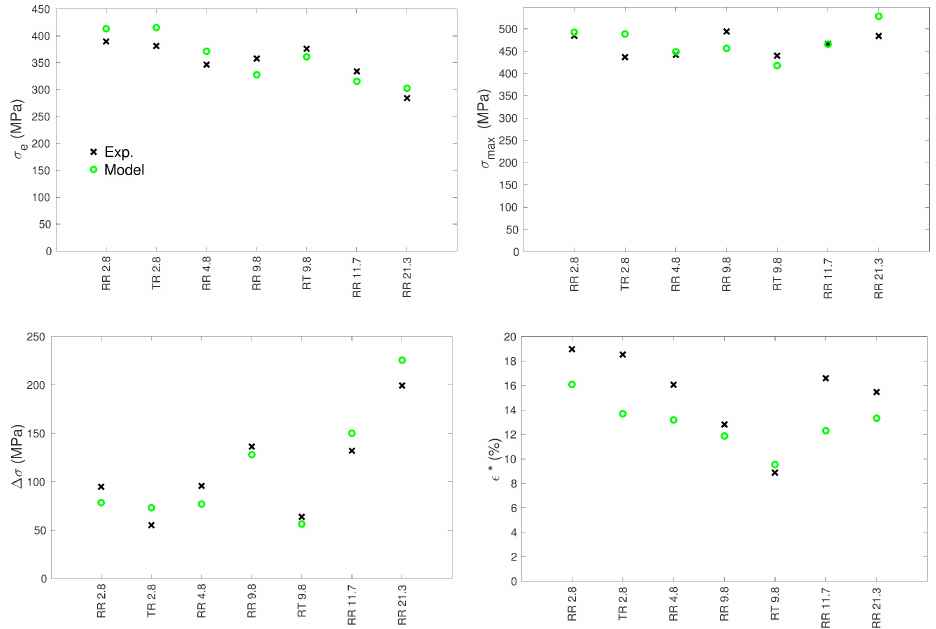
Figure 6. Comparisons between experimental and calculated values of σ e , σ max , ∆ σ and ε ∗ (see text for definitions).